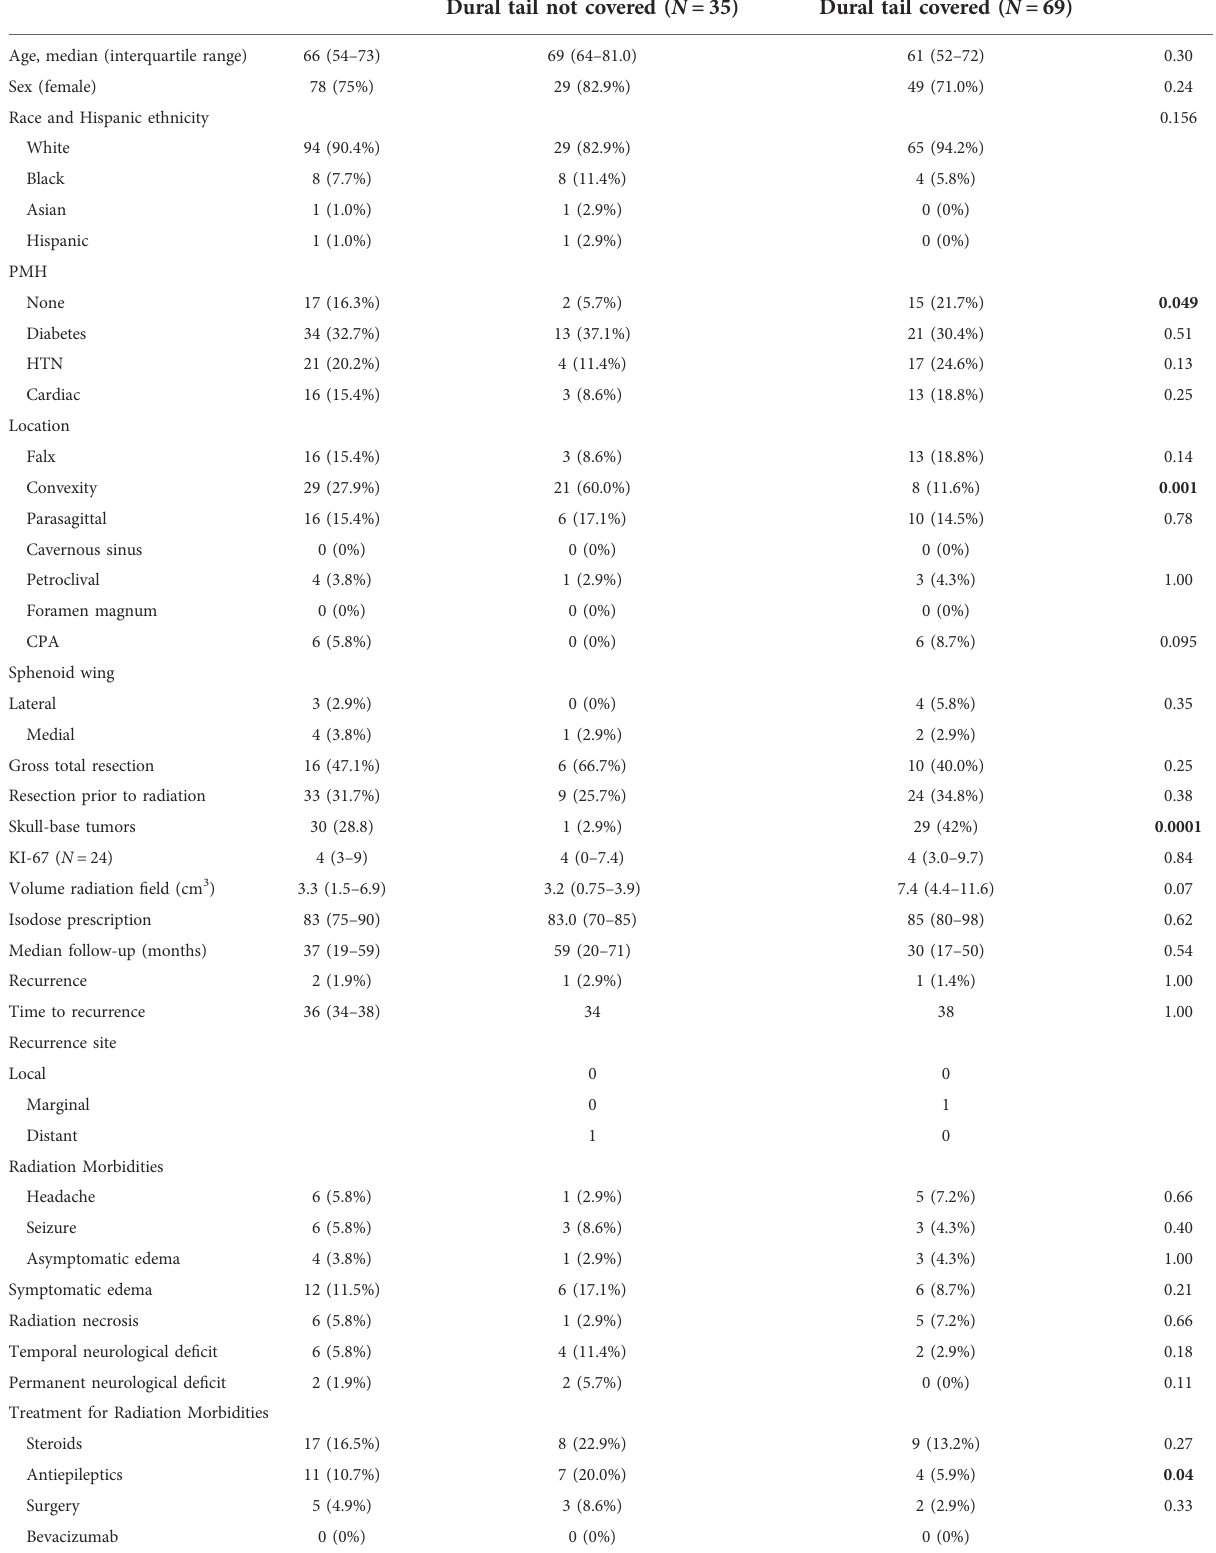
The bold means results are statistically signi fi cant at a p <